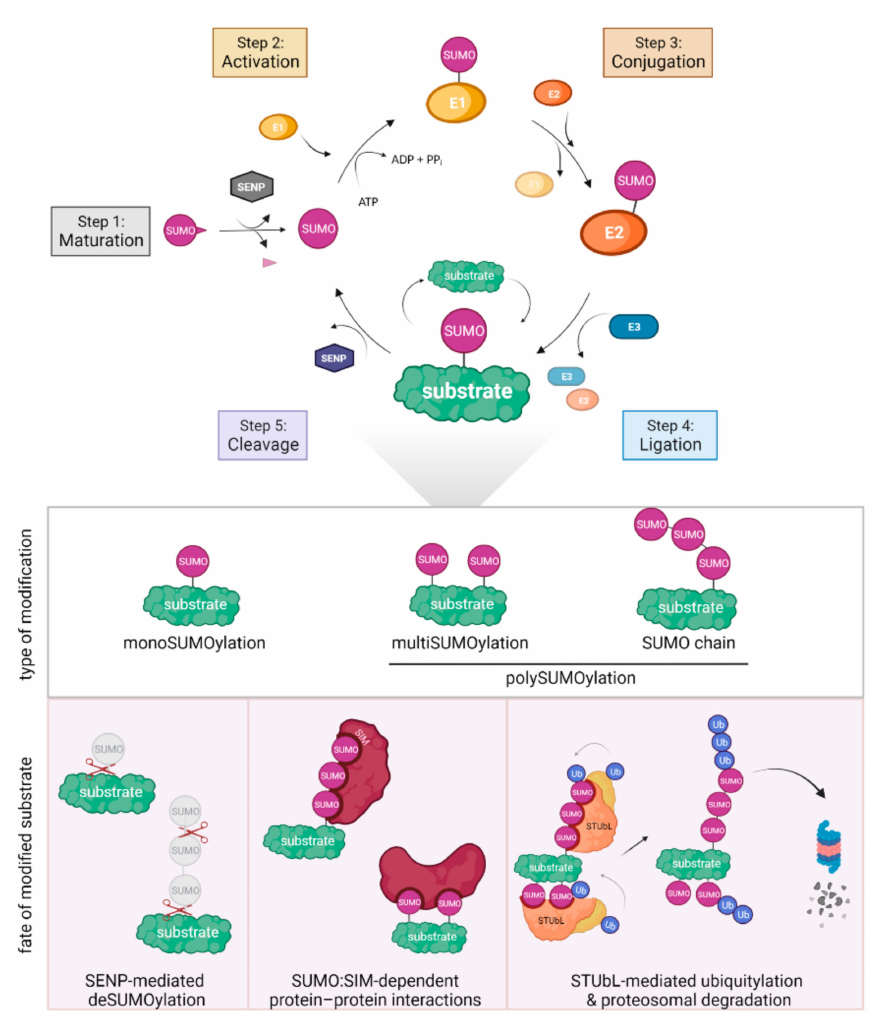
Figure 1. SUMO metabolism and functions. Top panel: cycle of SUMOylation. Bottom panel: function of the different types of